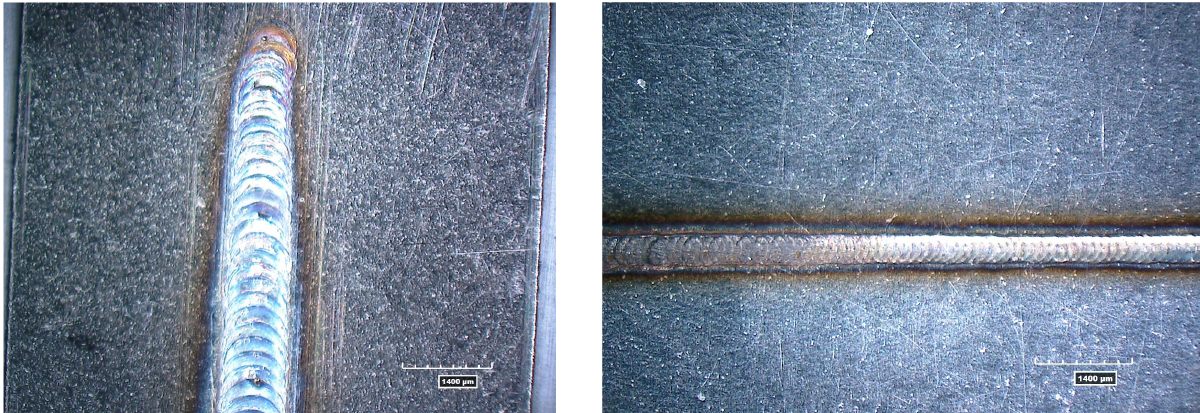
Figure 7: Continuous weld face consisting of spot welds for: on the left – the dissimilar joint 0H18N9/Ni, on the right – 0H18N9/0H18N9.